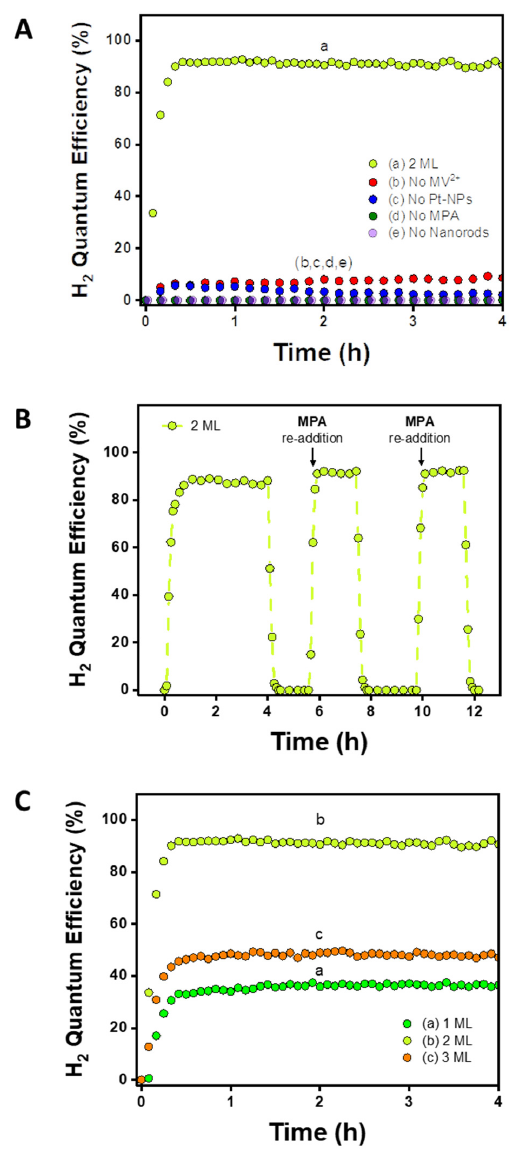
Figure 2. Photocatalytic H 2 evolution reactions. ( A ) Control experiments where MV 2+ , Pt-NPs, MPA, and 2 ML NRs are omitted independently. Solutions were irradiated at 405 nm. Conditions unless stated otherwise: NR absorbance set to 1 at 405 nm, 4.5 mM MV 2+ , 136 mM MPA, 0.8 mM Pt-NPs, 50 mM pH 6.2 phosphate buffer, 5 mW. ( B ) 2 ML nanorods irradiated at 405 nm with re-addition of the hole scavenger (MPA). ( C ) Comparing the activity of 1, 2, and 3 ML NRs, irradiated at 405 nm. Monitoring Hole Extraction. The trend for photocatalytic activity by which 2 ML outperforms 3 ML is in accordance with Zamkov and coworkers’ work and our original aim to improve extraction of holes from the CdSe core via a reduced CdS shell thickness. However, the observation that the 2 ML samples also improve upon the activity of the ultra-thin 1 ML samples calls for further examination. Thus, we first set out to verify the exact role and significance of hole extraction from the NRs in determining the relative